Question: What style of plot is this figure drawn as?
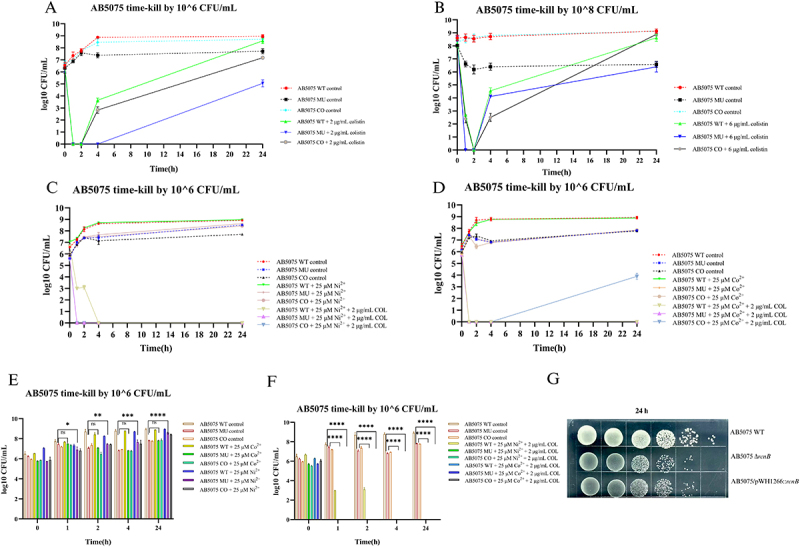
Answer: line